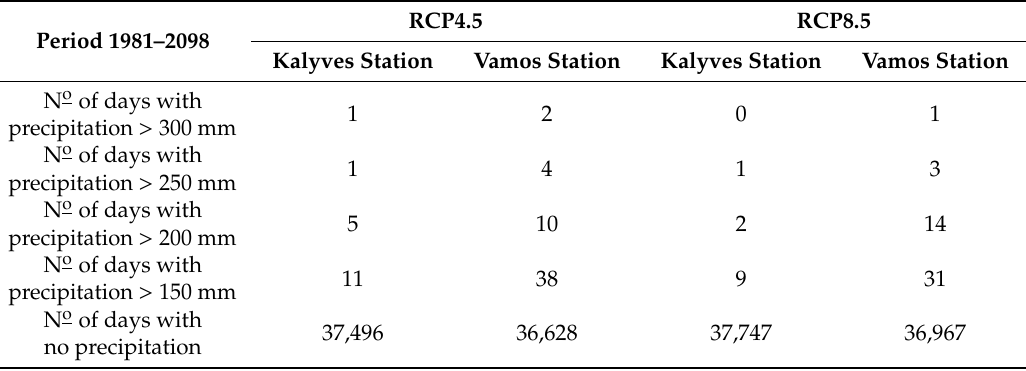
Table 2. Analysis of rainy days on a daily basis, of neighboring stations to the area of interest